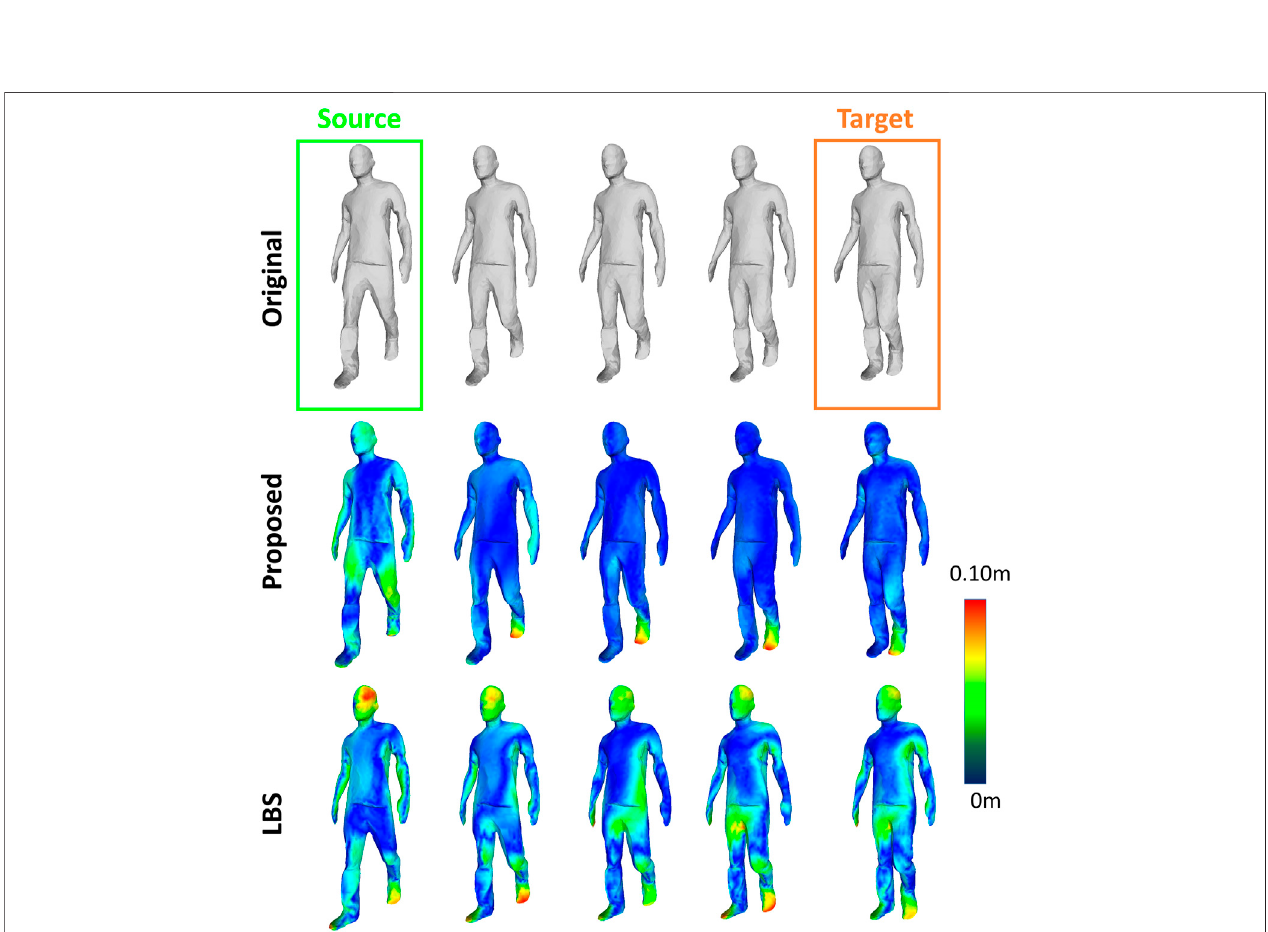
FIGURE 8 | Interpolation between two frames from the original motion sequence surrounded with a green and orange box. The top row represents the original sequencecomposedof fi veconsequentframes.Themiddlerowistheresultofinterpolatingthelearntlatentvectoroftheproposednetwork.Thebottomrowistheresult of using linear blend